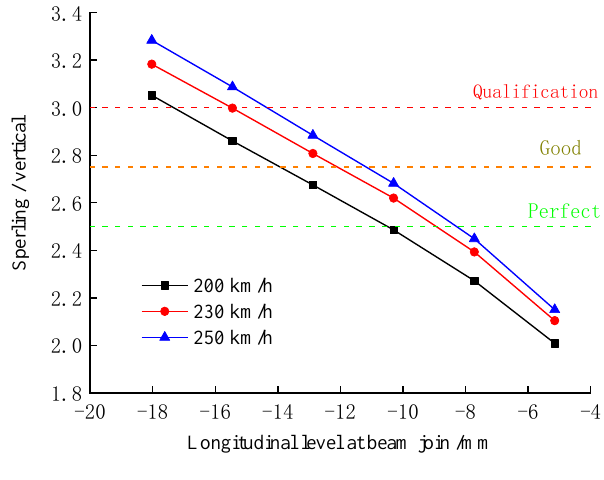
Figure 19. Sperling/vertical.